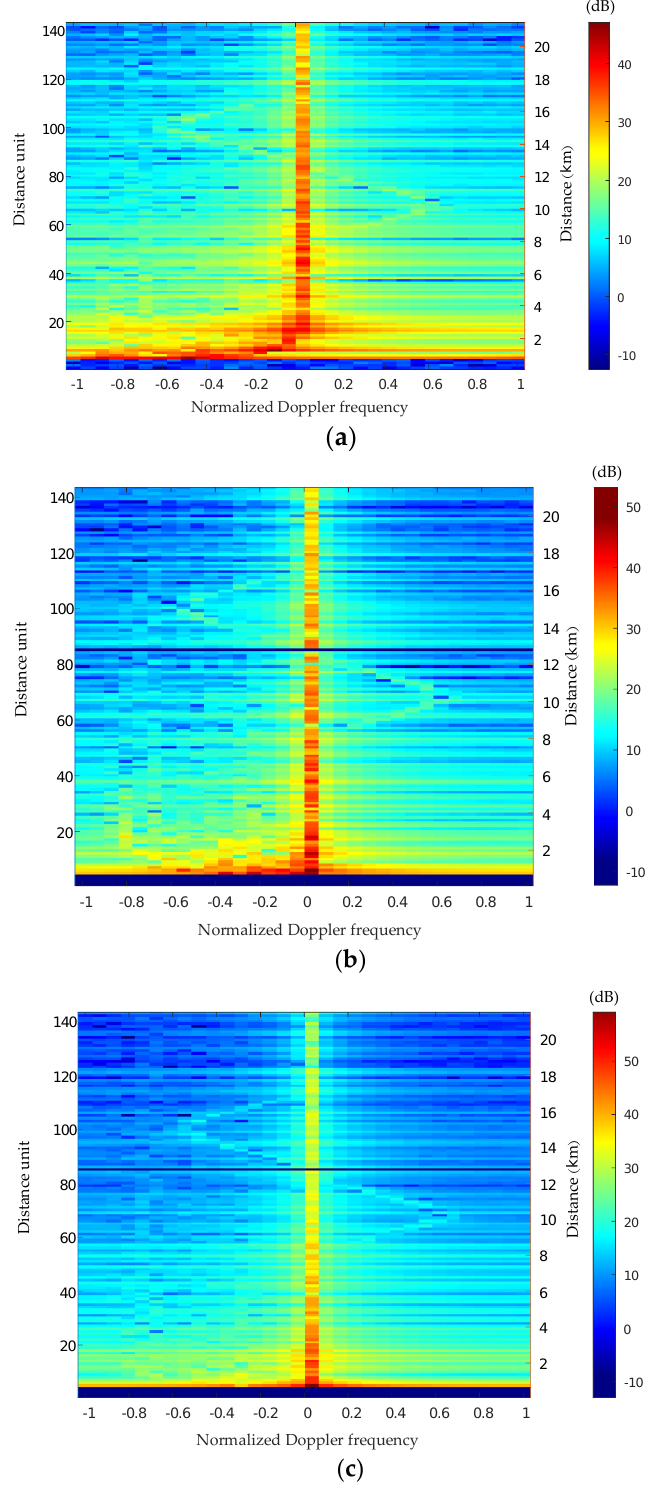
Figure 5. Comparison of Distance-Doppler spectra before and after compensation of fuselage frustum conformal array. ( a ) before compensation ( b ) after DW compensation ( c ) this paper. As can be seen from Figure 5a, the ground clutter signal is mainly concentrated on